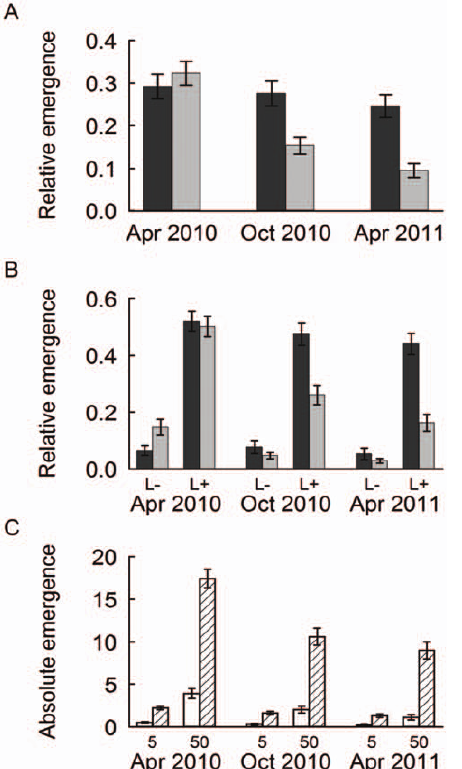
Figure 3. Average seedling emergence in relation to plot size, propagule pressure and litter. Seedling emergence (proportion of sown seeds) in large (0.1 m 2 , black bars) and small plots (0.01 m 2 , grey bars) (A), proportion of sown seeds differentiated according to the litter treatment (L-, controls; L + , 400 g litter m 2 2 ) (B), and absolute number of emerged seedlings in relation to propagule pressure (5 or 50 seeds sown) and litter cover (white bars, controls; hatched bars, 400 g litter m 2 2 ) (C) in spring 2010 (Apr 2010), after the first summer (Oct 2010) and one year after first emergence (Apr 2011). Data are means 6 s.e., n=120 in a. and 60 in b. and c.